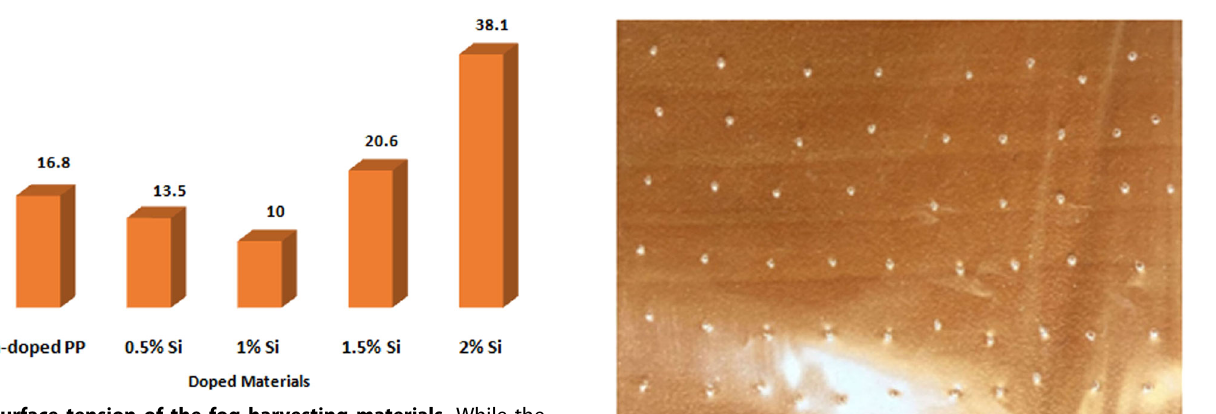
Fig. 5 Surface tension of the fog harvesting materials. While the surface tension of pure polypropylene was 16.754 mN/m, the surface tension decreased to 13.512 and 9.992 mN/m when 0.5 and 1% fumed silica was doped, respectively.